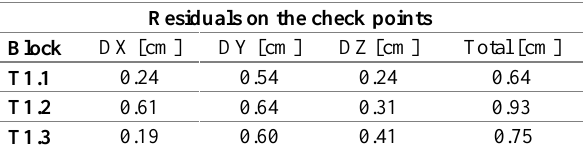
Table 3 – Statistics of the residuals in X, Y and Z